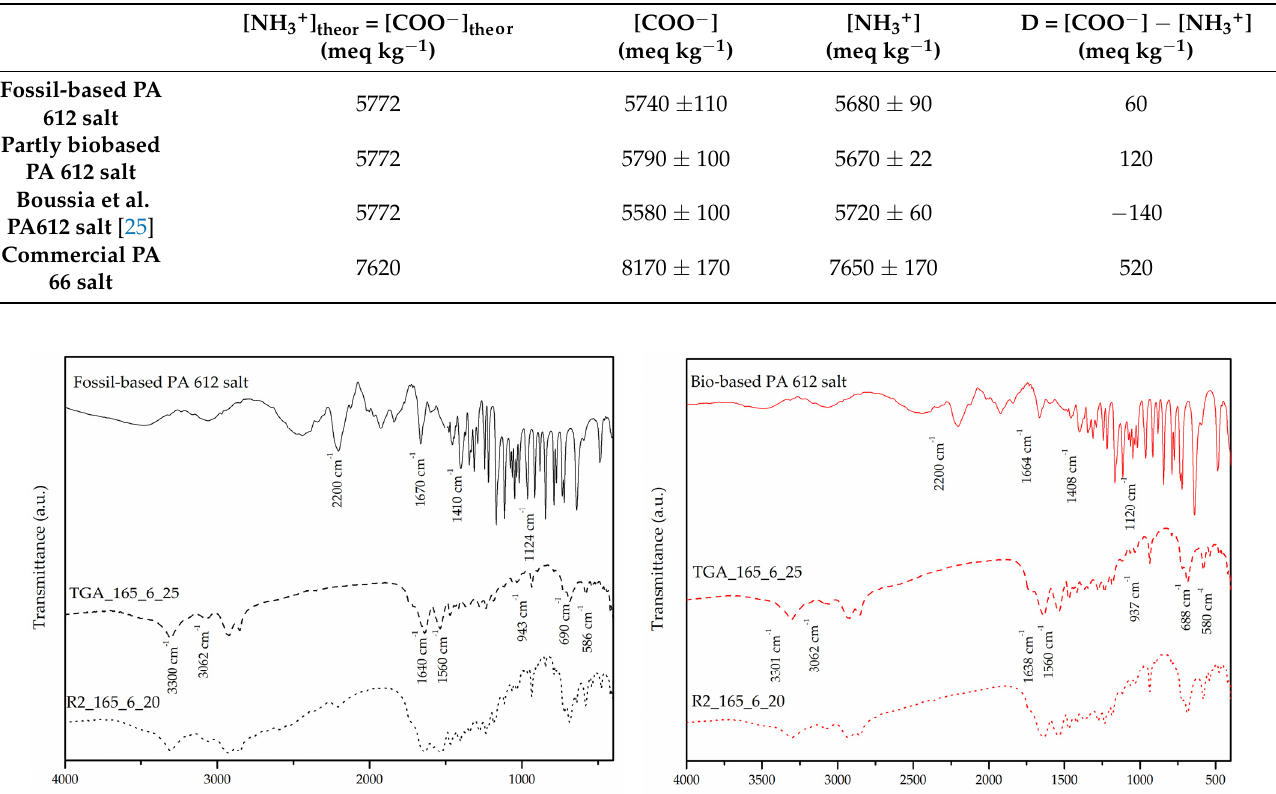
Table 2. End-group concentrations of PA 612 salts.